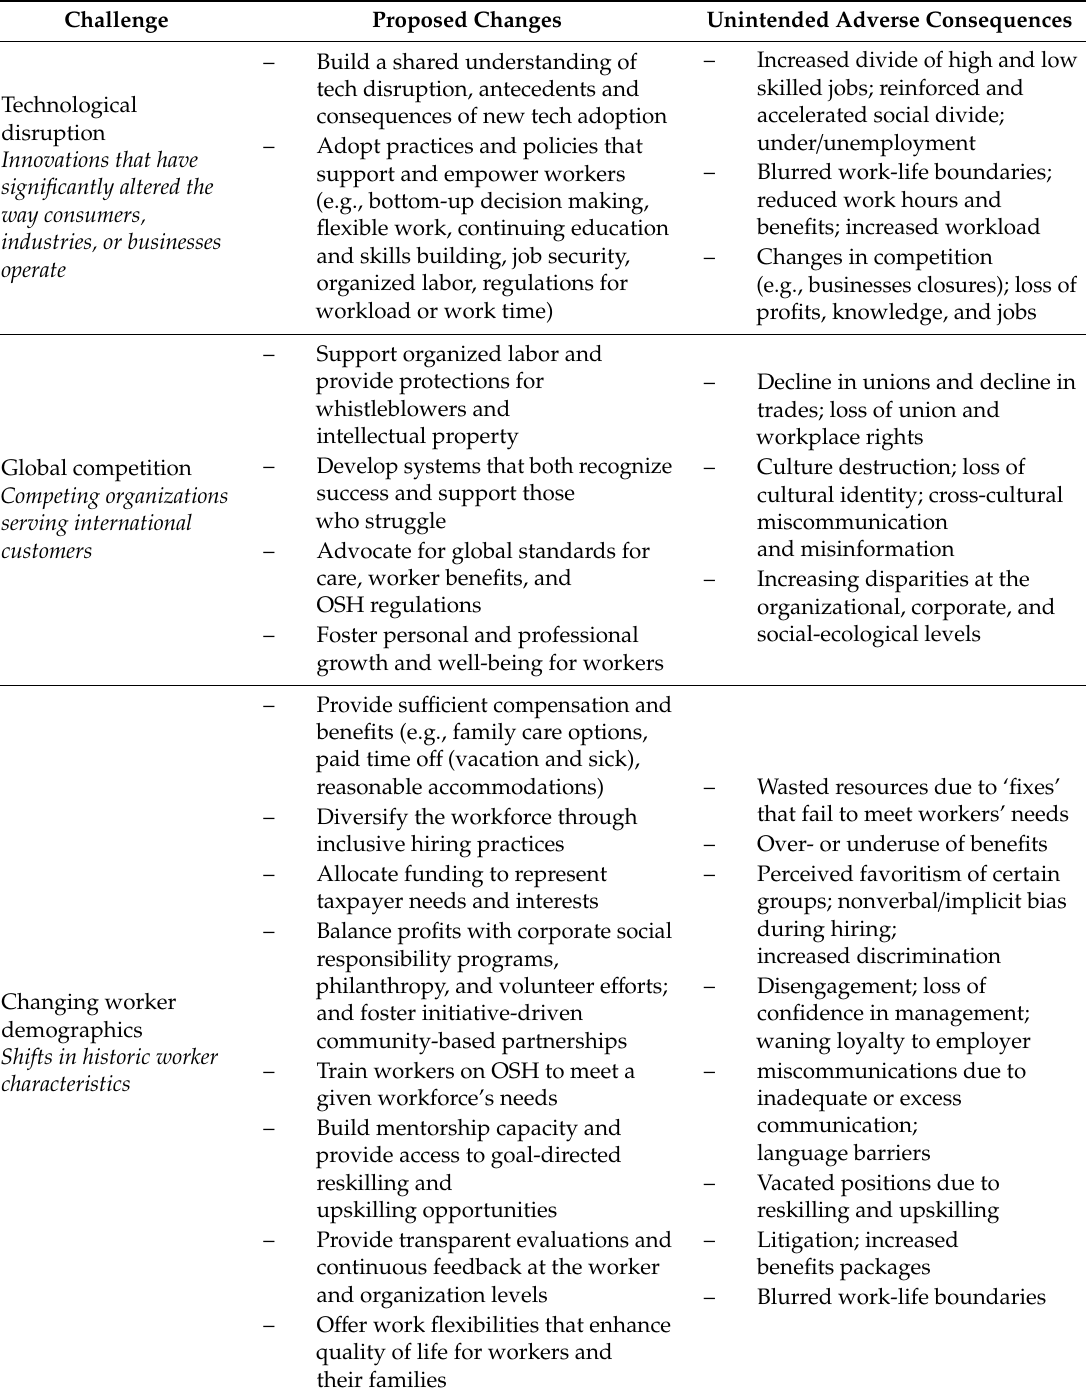
Table 2. Systems approach to occupational safety and health (OSH) pressing issues *.